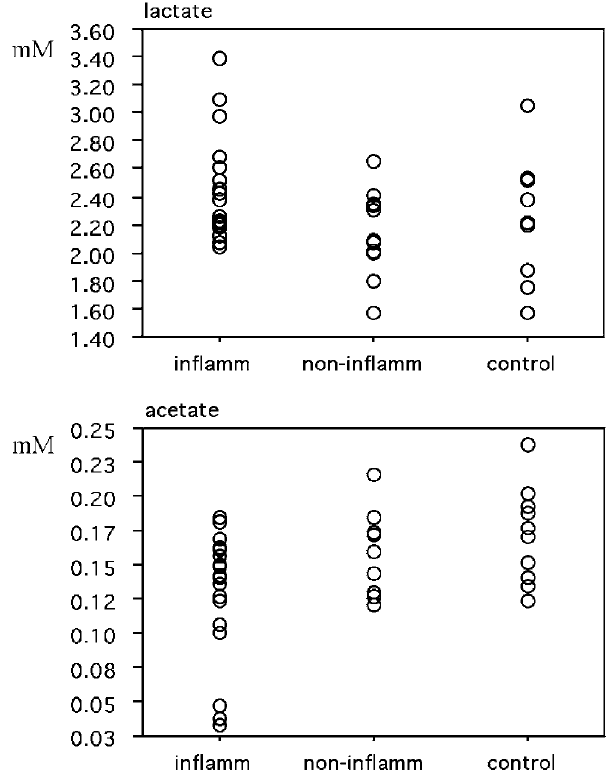
Figure 3. Scattergrams for lactate and acetate CSF concentrations [mM] in patients with or without inflammatory brain MS plaques (abbreviated ‘inflamm’ and ‘non-inflamm’, respectively), and con- trols. Marked deviations from normal distribution are readily recog- nized for lactate (inflamm) since data are clustered at low values (around 2.2 mM), but also for acetate (inflamm) where data are clustered at high values (around 0.16 mM).